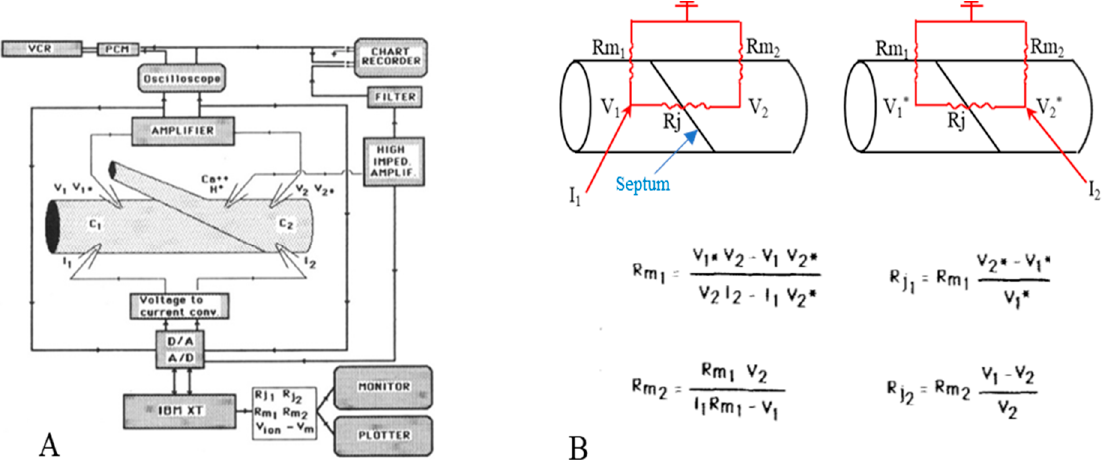
Figure 1. Diagram of electrical recording setup ( A ). Current pulses are injected via current microelectrodes (I 1 , 1 2 ) alternatively in the posterior (C 1 ) and anterior (C 2 ) axon segments. The resulting potentials (V 1 , V 2 , V 1 *, V 2 *) are displayed in the chart recorder and the oscilloscope. The voltage signal (V ion ), recorded by the ion-selective microelectrode, is displayed in the chart recorder after subtraction of membrane potential (V m ). ( B ). Equivalent circuit and equations used to calculate junctional (Rj 1 , Rj 2 ) and non-junctional (R m1 , R m2 ) resistances. Adapted from [21].